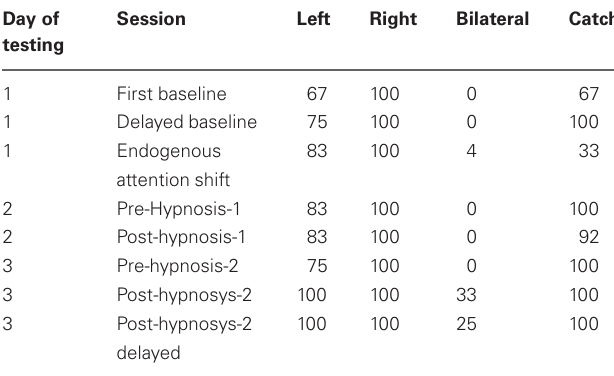
Table 1 | Testing for